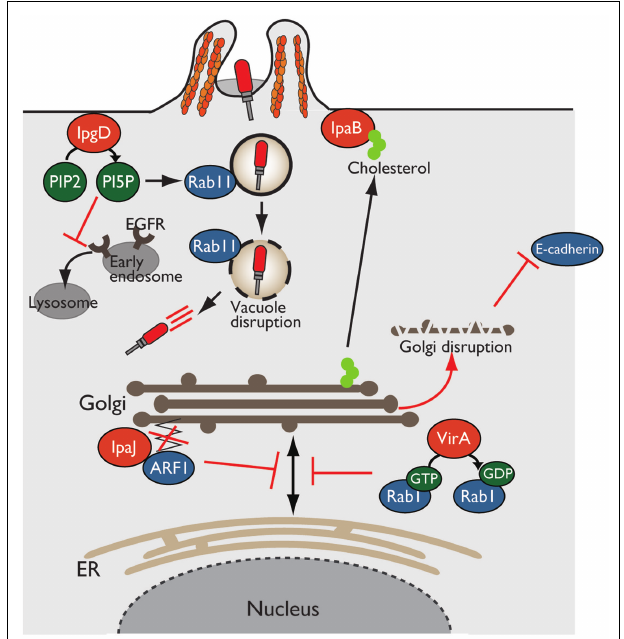
FIGURE 4 | Shigella alters host intracellular trafficking . Shigella exploits and alters intracellular trafficking to manipulate the host defense system. PI5P produced by IpgD recruits Rab11 to the bacterial entry site and promotes vacuolar membrane disruption. Production of PI5P by IpgD further relocates EGFR in early endosomes, resulting in blocking lysosomal degradation of EGFR and sustaining PI3K–Akt survival pathway. VirA and IpaJ target and inactivate Rab1 and ARF1, respectively, thereby preventing intracellular trafficking and Golgi disruption. IpaB binds to and relocates cholesterol from Golgi to bacterial entry sites, resulting in Golgi